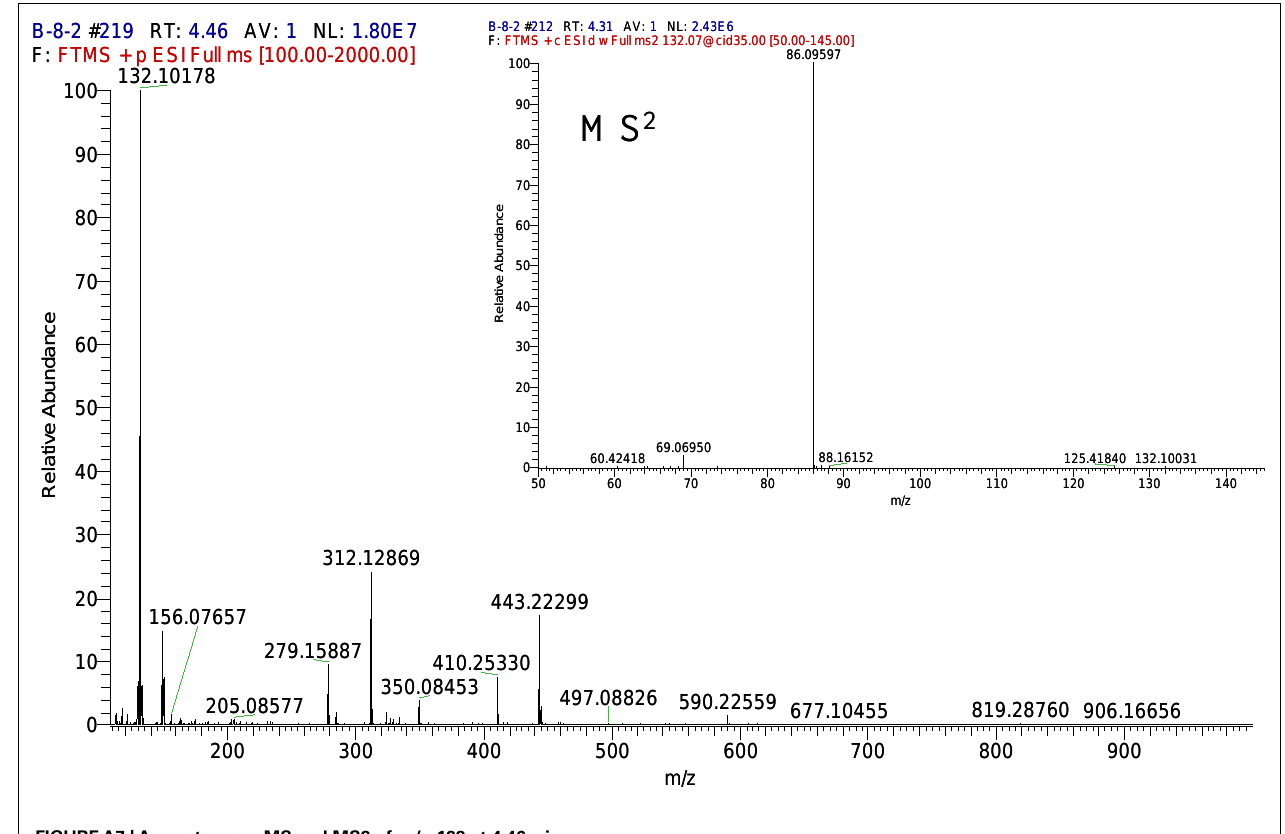
FIGUREA7 |Accurate mass MS and MS2 of m / z 132 at